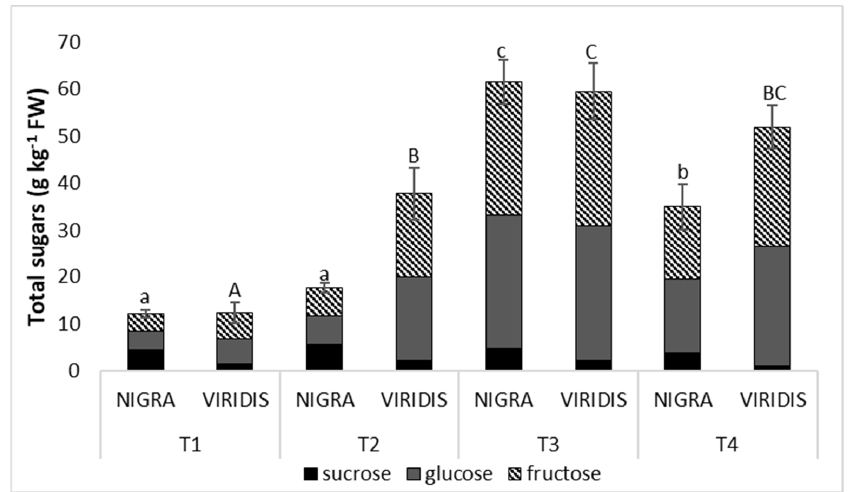
Figure 2. Content of each sugar and total sugars (g kg − 1 FW) of Sambucus nigra (NIGRA) and S.